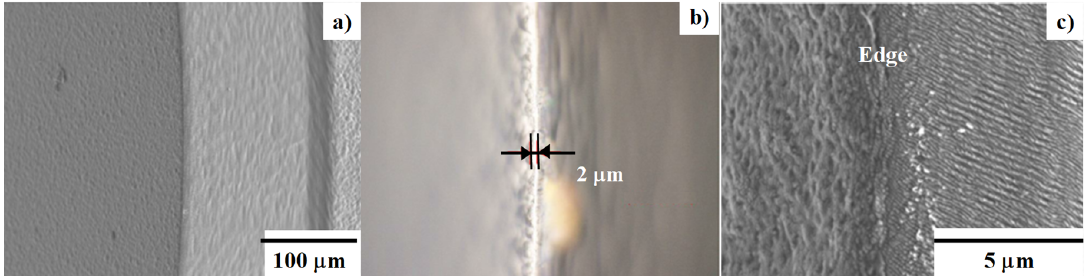
Figure 5. SEM and LM images on the trimmed CVD-diamond coating with different magnifications. ( a ) Overall trimmed surface, ( b ) measurement of the trimmed edge width by LM, and ( c ) the unidirectional formation of nanotextures on the trimmed side surfaces of the diamond coatings.